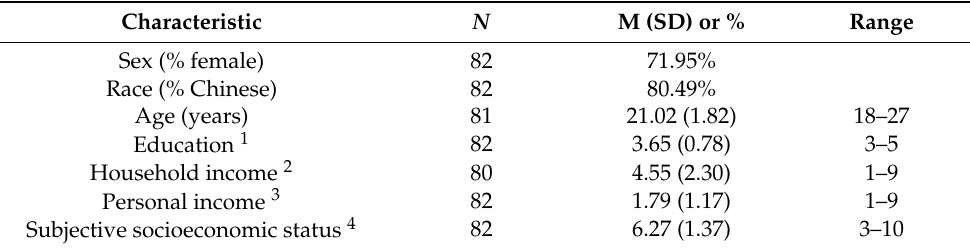
Table 1. Participant Characteristics in Study